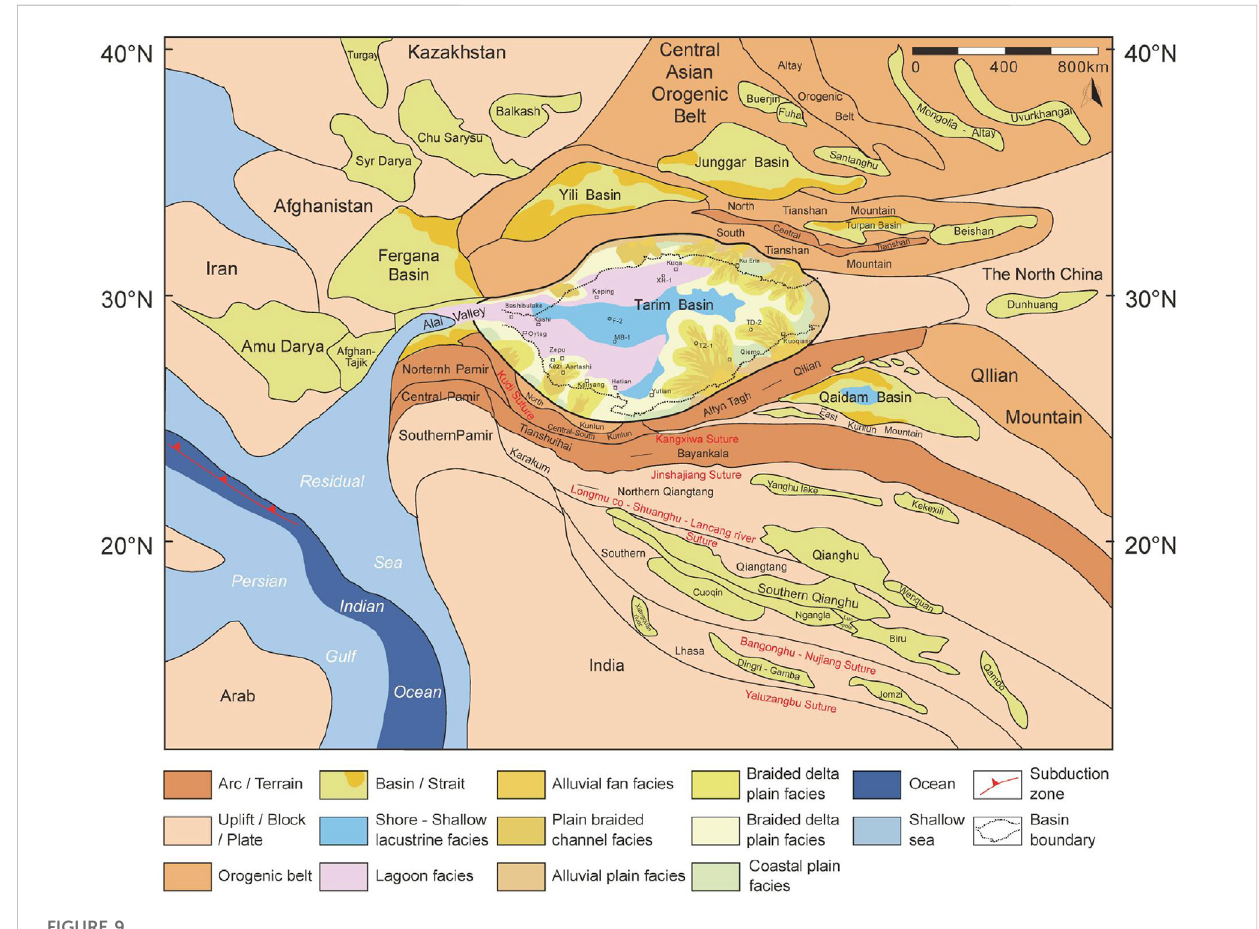
FIGURE 9 Tectono-paleogeography map around the Tarim Basin in the late